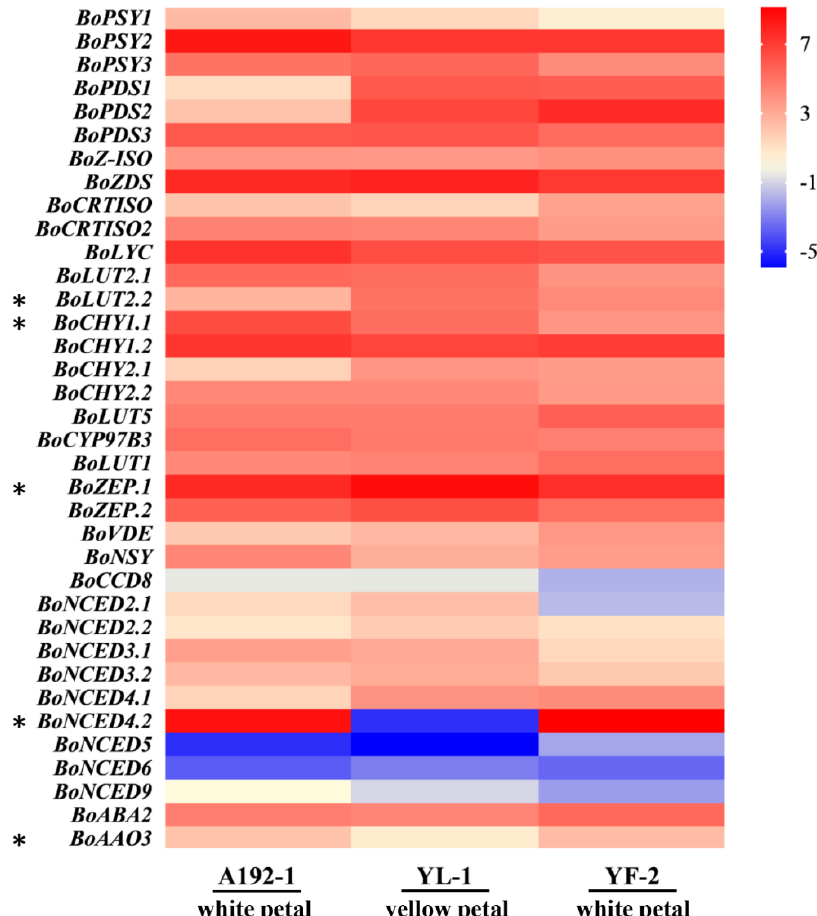
Figure 4. Heatmap of gene expression patterns involved in the carotenoid biosynthetic pathway in A192 − 1, YL − 1 and YF − 2. The heatmap was constructed according to the FPKM average values. The color scale represents the highest and lowest levels of expression, and the rows and columns in the heatmap represent samples and genes, respectively. The asterisks represent significant differences in both A192 − 1 and YF − 2 petals ( p < 0.05).